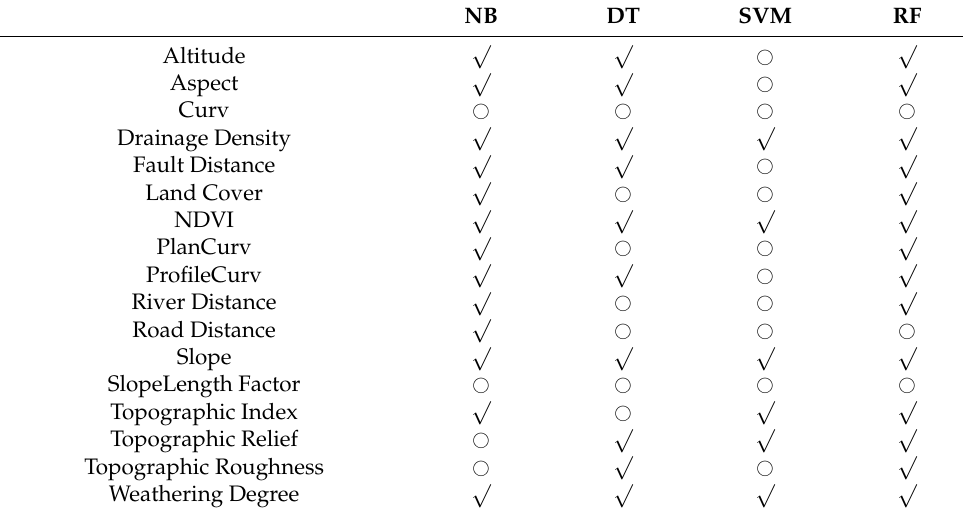
Table 9. Results of attribute feature selection for different